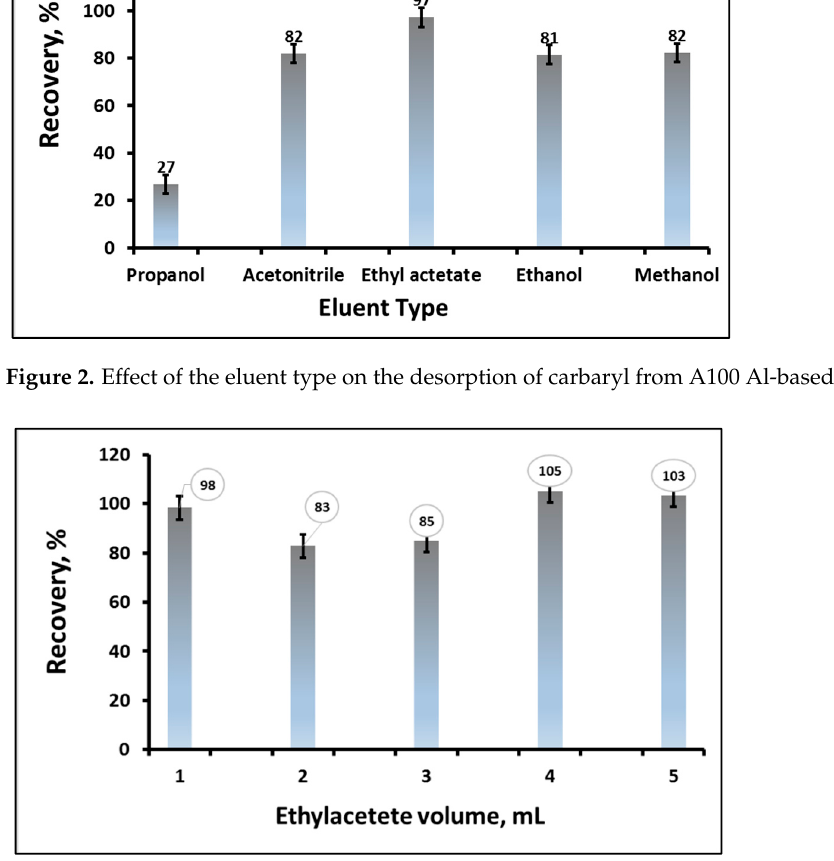
Figure 2. Effect of the eluent type on the desorption of carbaryl from A100 Al-based MOFs ( n = 3).